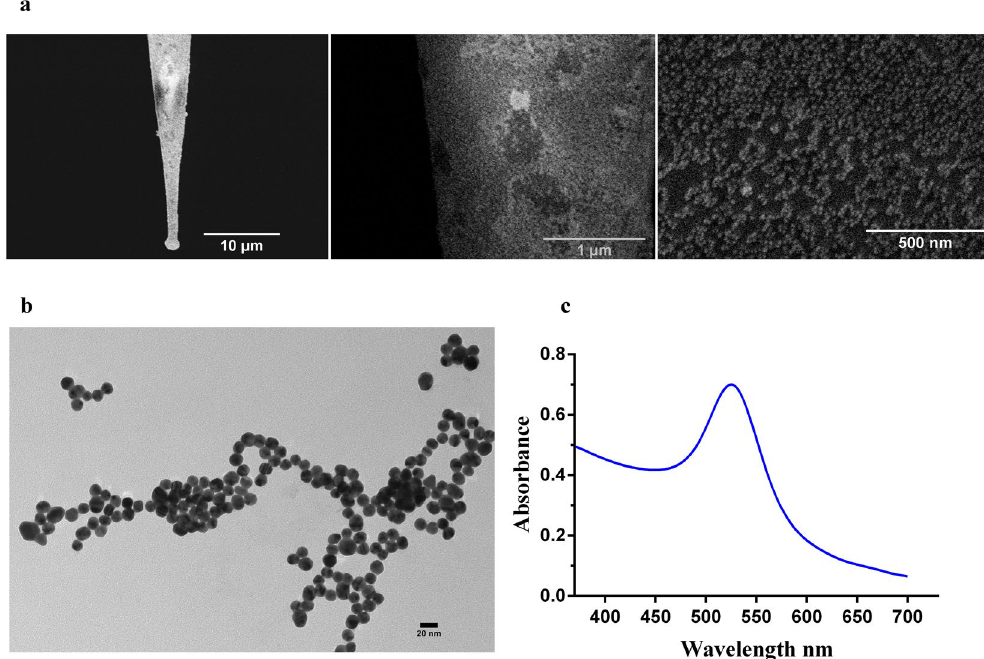
Figure 1. Fabrication of the nanoelectrodes. ( a ) SEM images of an Au nanoelectrode at three magnifications: scale bars 10 μ m, 1 μ m and 500 nm. The nanoelectrodes used for cell stimulation were fabricated by coating Au nanoparticles onto glass micropipettes, which was facilitated by functionalization of the glass surface with a 10% volume solution of γ –(aminopropyl) tri-ethoxysilane. ( b ) A TEM image of the Au nanoparticles which were synthesized using a liquid phase method. A 2–3 ml solution of 1% trisodium citrate was added to a boiling solution of